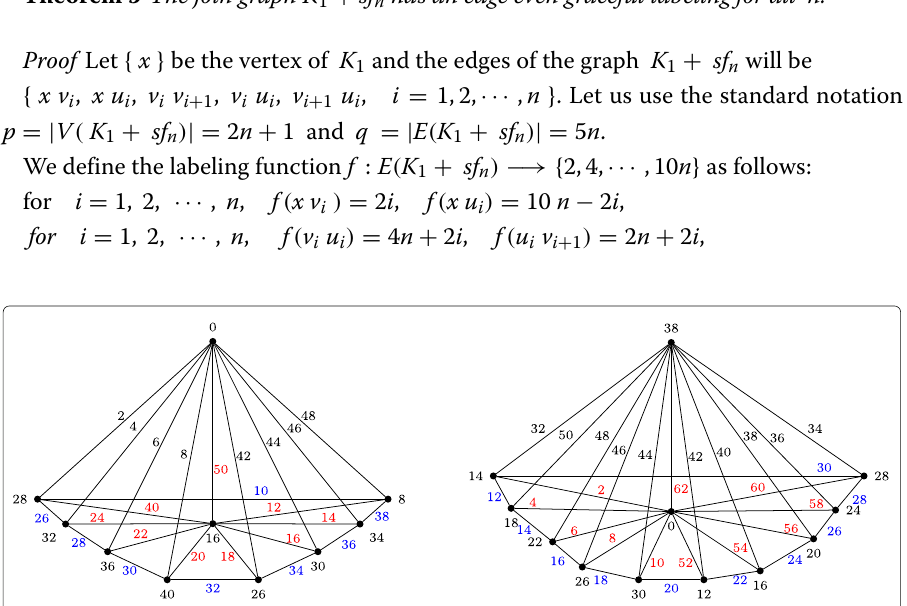
Fig. 3 An edge even graceful labeling of the graphs K 1 + W 8 and K 1 + W